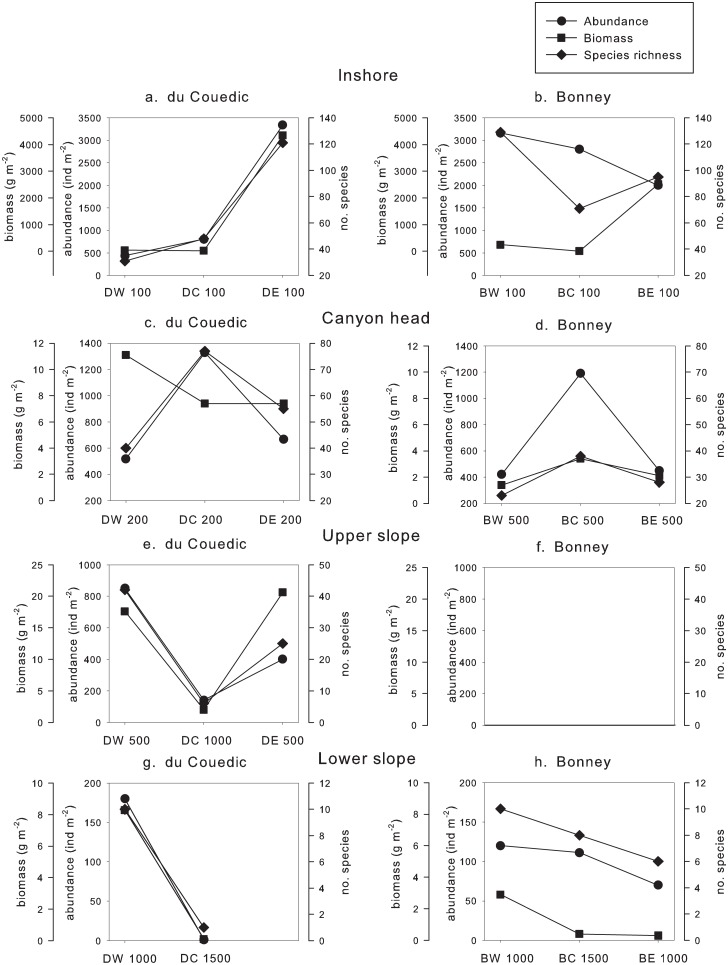
Cross-canyon abundance (circle), biomass (square) and species richness (diamond) inshore (a and b), at the canyon head (c and d), on the upper slope (e and f) and on the lower slope (g and h) inside (C) and outside (to west (W) and east (E)) of du Couedic (D) and Bonney (B) Canyons.“Upper and lower slope” are relative terms spanning the range of this study. There were no data for (f) or for DE 1000. Distances between stations are shown in Fig 2. Station codes are as in Fig 2.